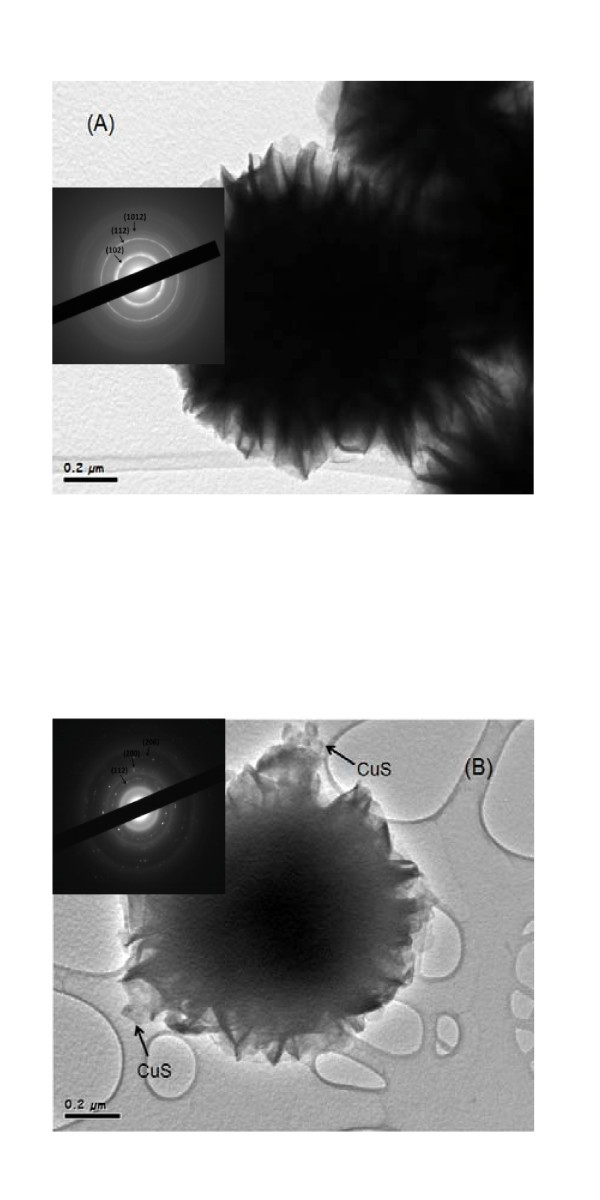
TEM images (A) ZnIn2S4 and (B) CuS/ZnIn2S4.